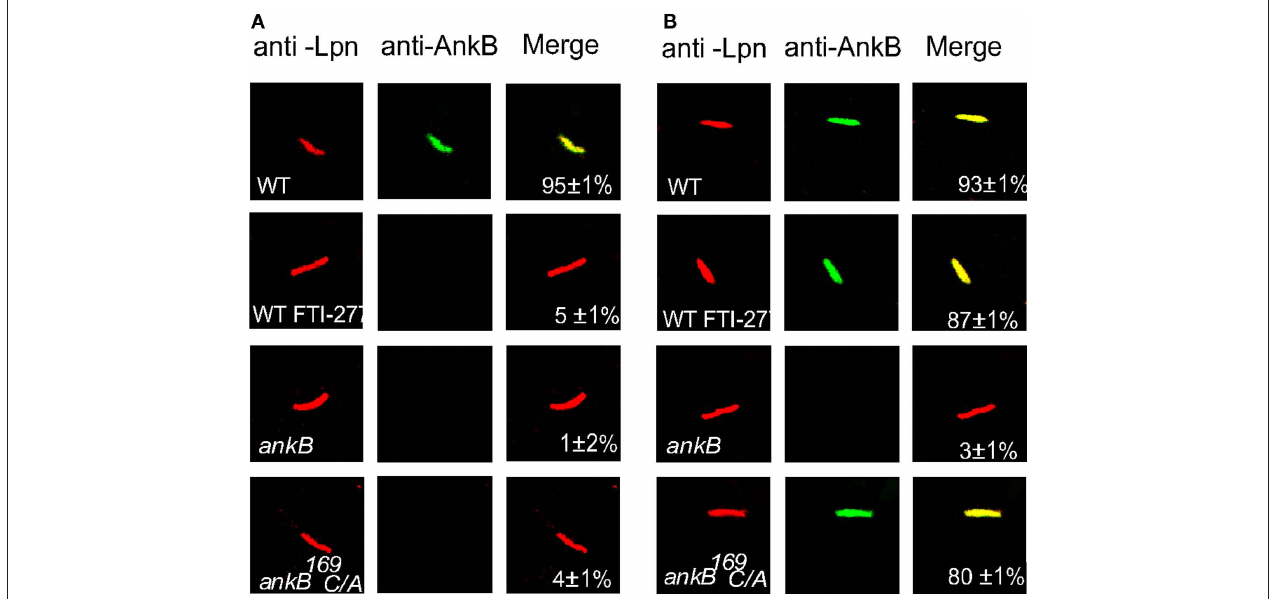
FIguRe 5 | Farnesylation by D. discoideum anchors AnkB to the LCV membrane. The infection was performed for 1 h and the cells were lysed at 2 h post-infection. The LCVs were isolated from untreated or FTI-277-treated D. discoideum . The LCVs were labeled with (A) anti-AnkB antibodies prior to permeabilization (green). After permeabilization, the LCVs were labeled with